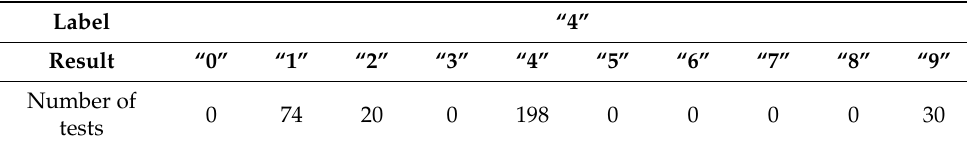
Table 3. Experiment test results of moving digits in Figure